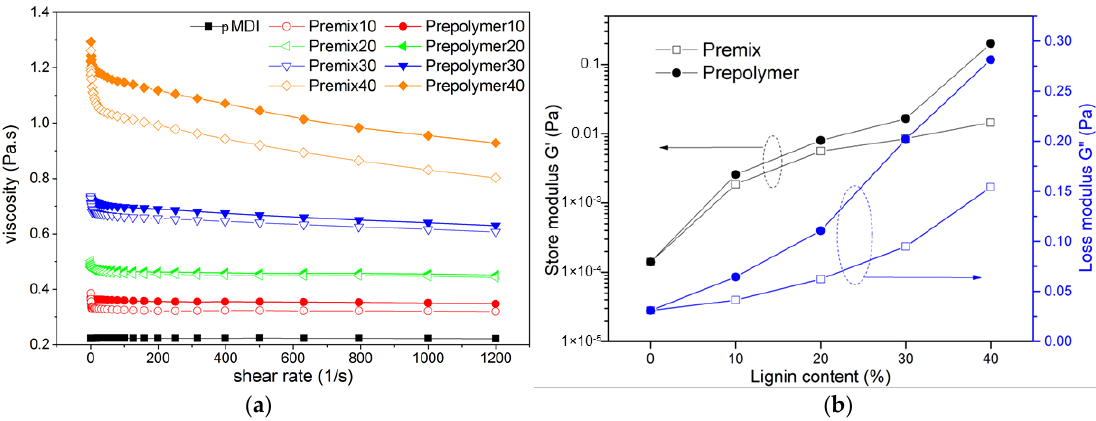
Figure 1. ( a ) Viscosity vs. shear rate curves of raw polyisocyanate methyl diphenyl diisocyanate (pMDI) resin (black), lignin-pMDI premix (hollow symbols), and lignin-pMDI prepolymer (solid symbols) containing 10–40% lignin; ( b ) storage (G′) and loss (G″) modulus of various lignin-pMDI premixes and the prepolymers at an angular frequency of 0.1 rad/s.